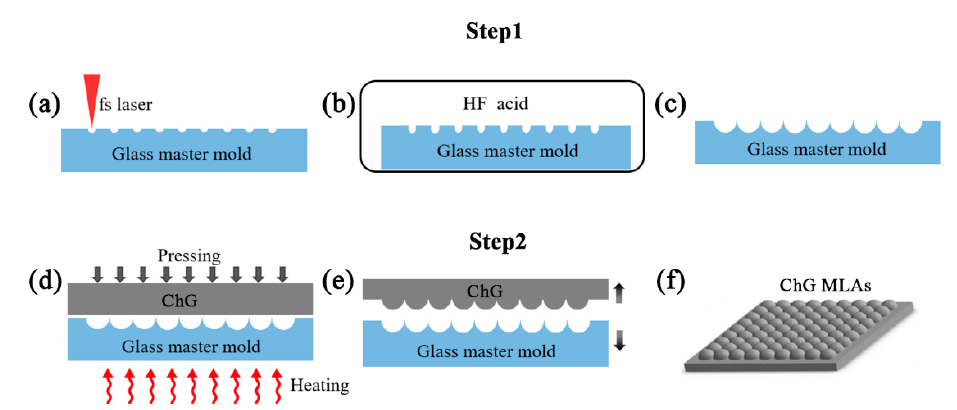
Figure 1. Schematic of the fabrication process. ( a ) An array of laser-exposed craters is produced on BK7 glass by laser irradiation; ( b ) The craters are treated by ultrasonic-assisted HF etching; ( c ) Concave microlens arrays (MLAs) with smooth surfaces are formed; ( d ) The precision glass molding process; ( e ) Separate the chalcogenide glass (ChG) from the mold; ( f ) Convex ChG MLAs.